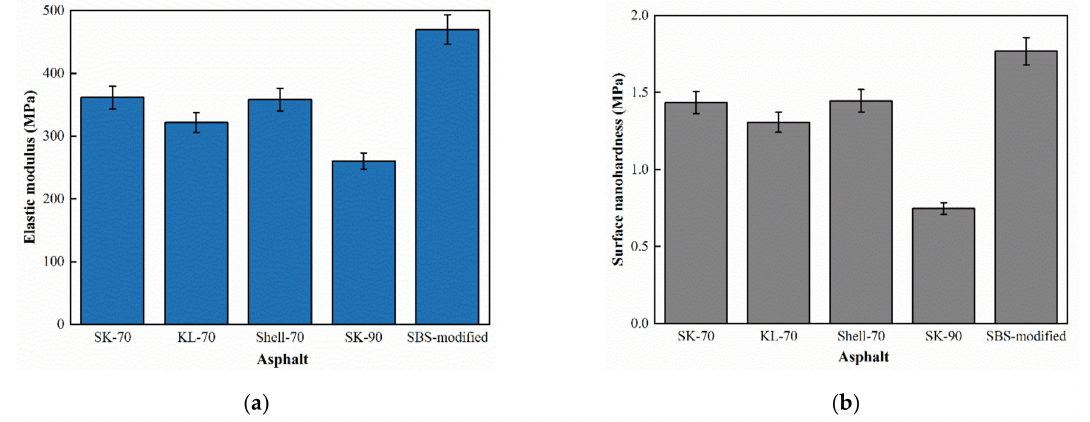
Figure 7. Surface micromechanical properties of original asphalt binder: ( a ) Elastic modulus and ( b ) Surface nanohardness.